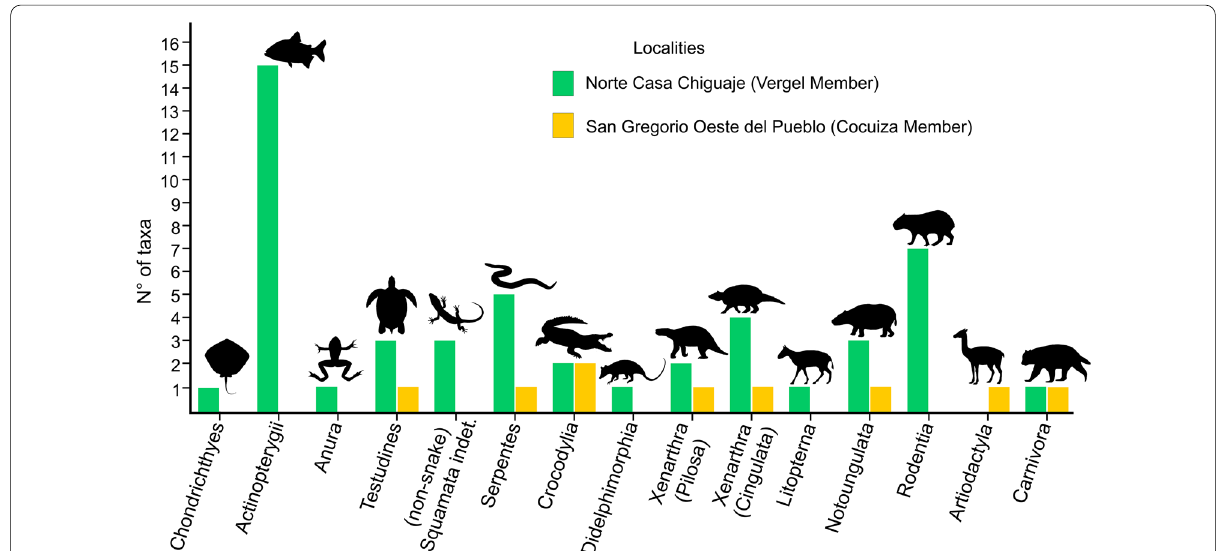
Fig. 31 Freshwater and terrestrial vertebrate diversity of the San Gregorio Formation by localities. Information based on Table